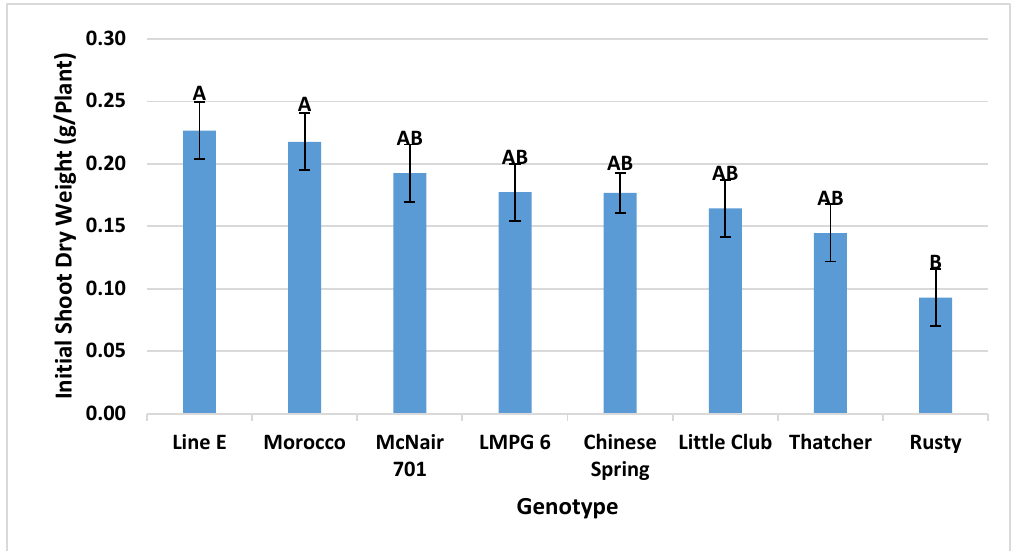
Figure 11. The initial dry weight (g) per plant (±SE) of the eight genotypes at 30 days after planting, prior to O 3 treatment in OPECs. Means within each exposure system were statistically separated using Tukey-Kramer adjustment for multiple comparisons. Means marked with the same letter are not significantly different at α = 0.05.